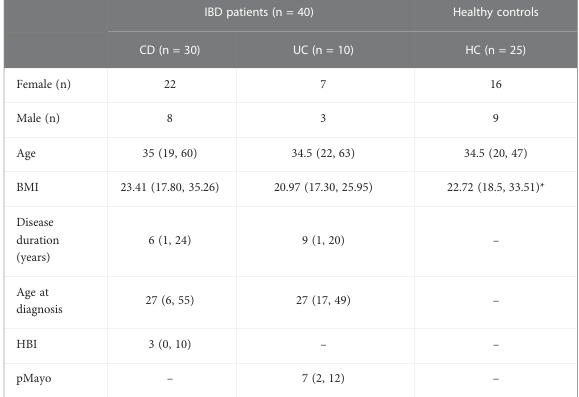
TABLE 1 Overview of IBD patients and healthy controls parameters included in the sequencing analysis at the time of their recruitment. IBD patients (n = 40)